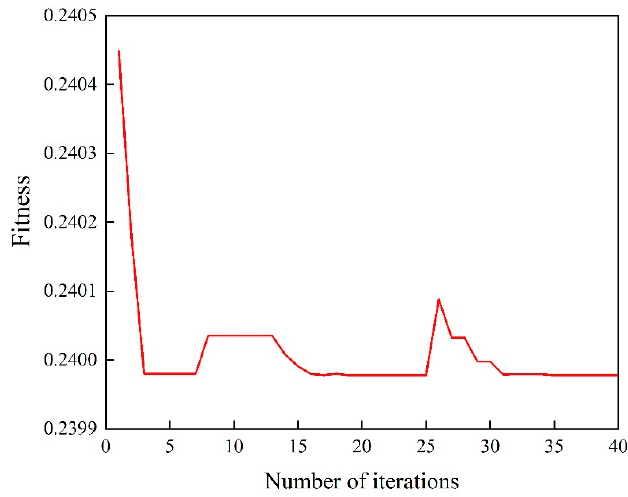
Figure 7. Optimization curve of the function fitness of the model of P max .